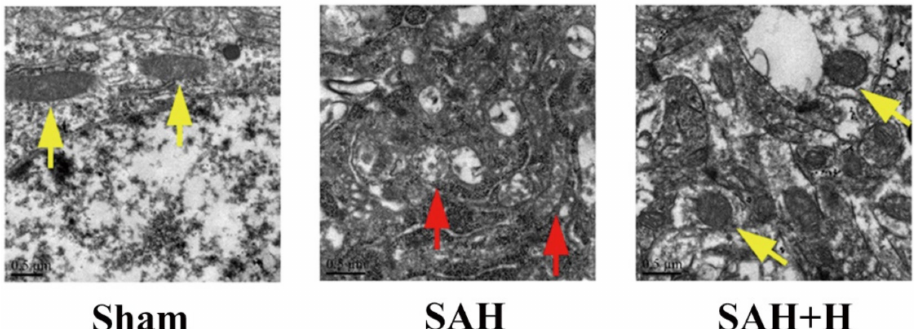
Figure 6. The transmission electron micrographs of neuronal mitochondria 1 d after SAH. Yellow arrows show normal mitochondrial morphology; red arrows point to abnormal mitochondrial